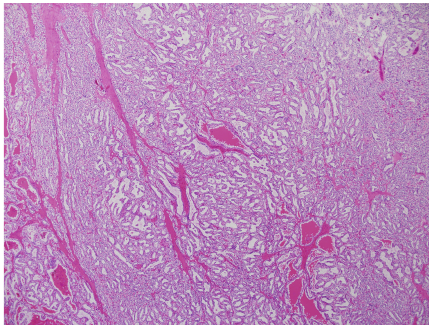
Figure 4: CK7 positive staining highlighting tubular and cystic